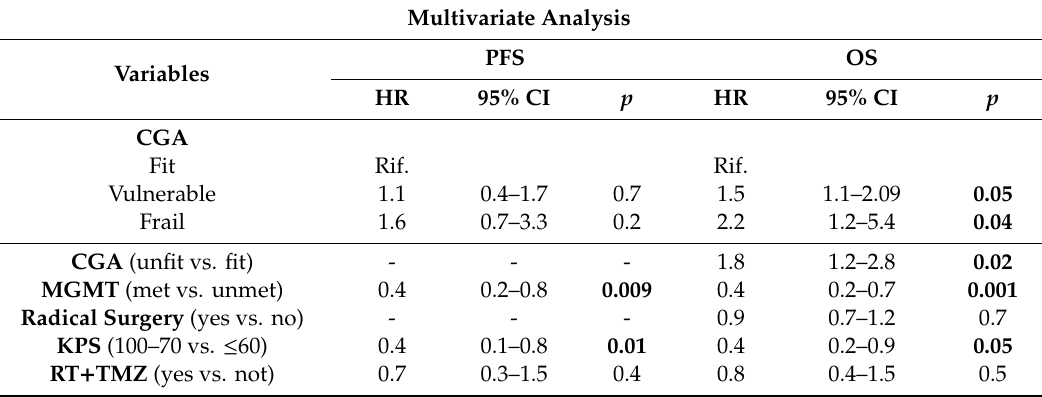
Table 4. Multivariate analyses of clinical factors associated with PFS and OS. Multivariate